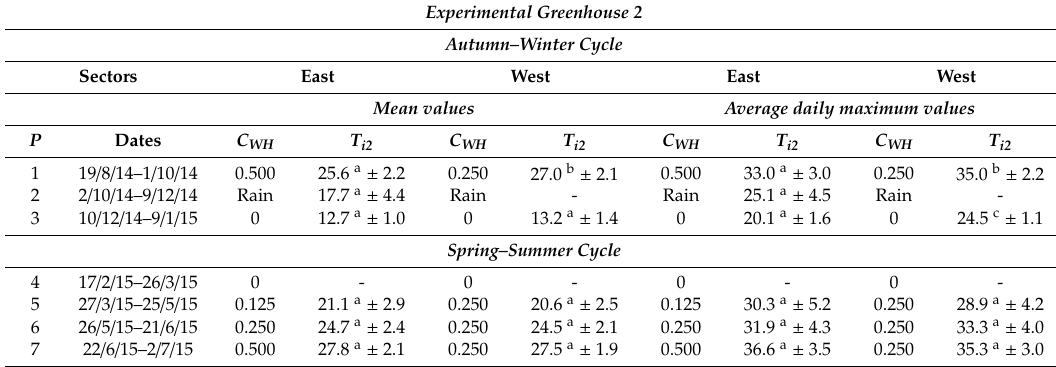
Table 4. Mean and average maximum ( ± standard deviation) values of air temperature recorded inside the east and west sectors of the experimental greenhouse 2 at 2 m height T i2 ( ◦ C) for the di ff erent periods P and whitening concentrations C WH (kg L − 1 ). Experimental Greenhouse